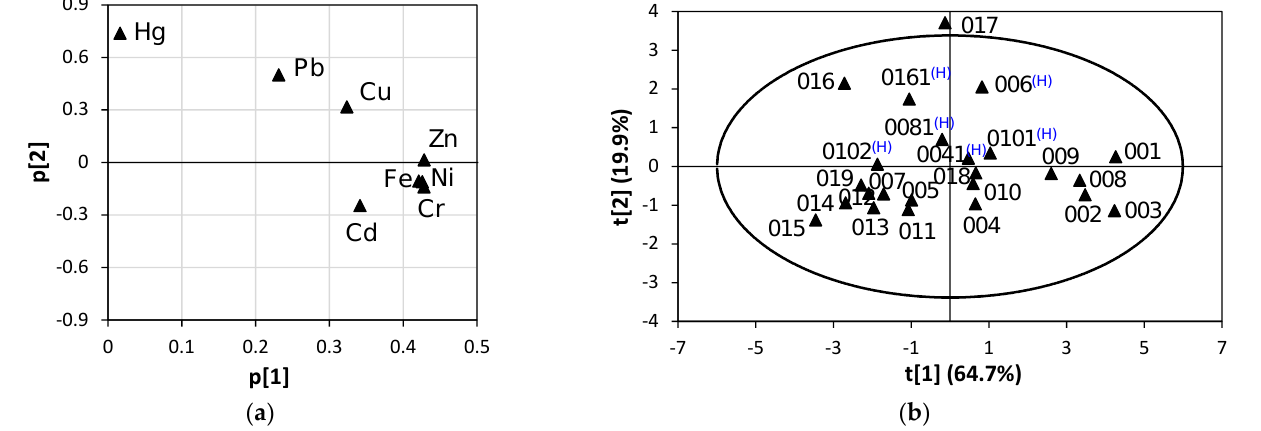
Figure 5. PCA results for the multivariate statistical analysis of the 7 metals in the sediments of the 24 Valencia water bodies: ( a ) loading-plot ( b ) score-plot. To facilitate identification of the water bodies, those including a port are labelled with (H).